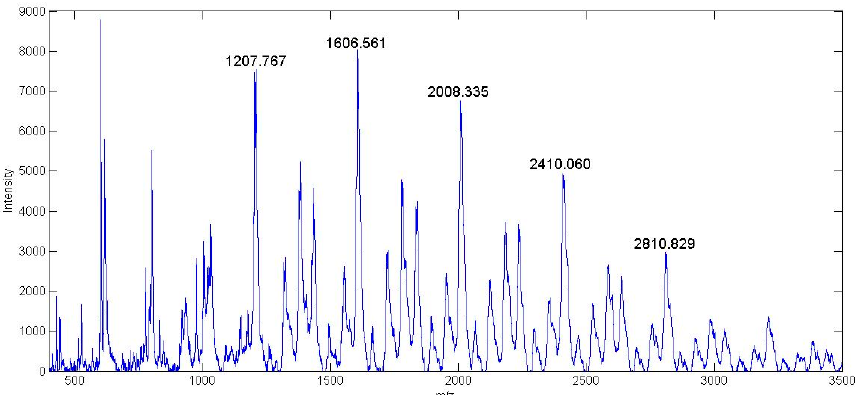
Figure 7. MALDI-TOF analysis of G1 NAP-HPAMAM.